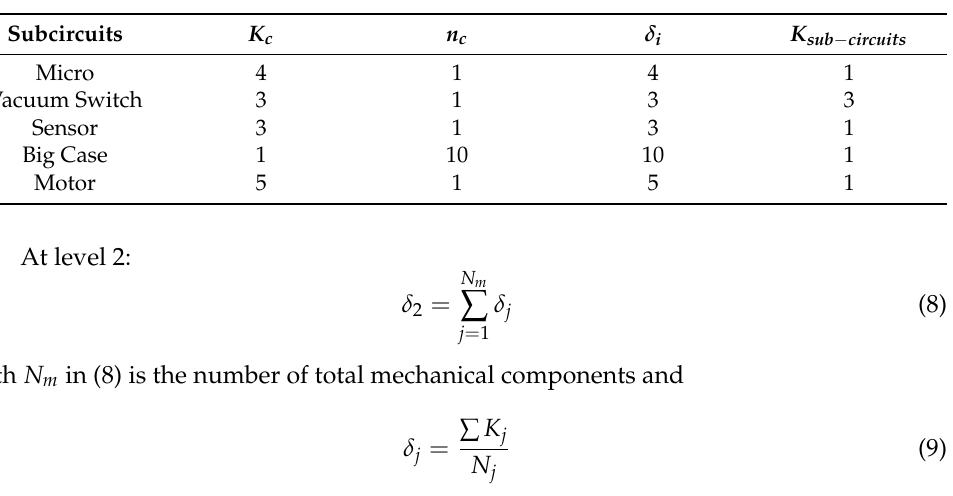
Table 5. Manufacturing data collected for Model A at level 1. Number of interfaces ( K c ) [count], number of components in a sub-circuit ( n c ) [count], interface constraint value ( δ i ) [count], number of sub-circuit interfaces ( K sub _ circuit ) [count].